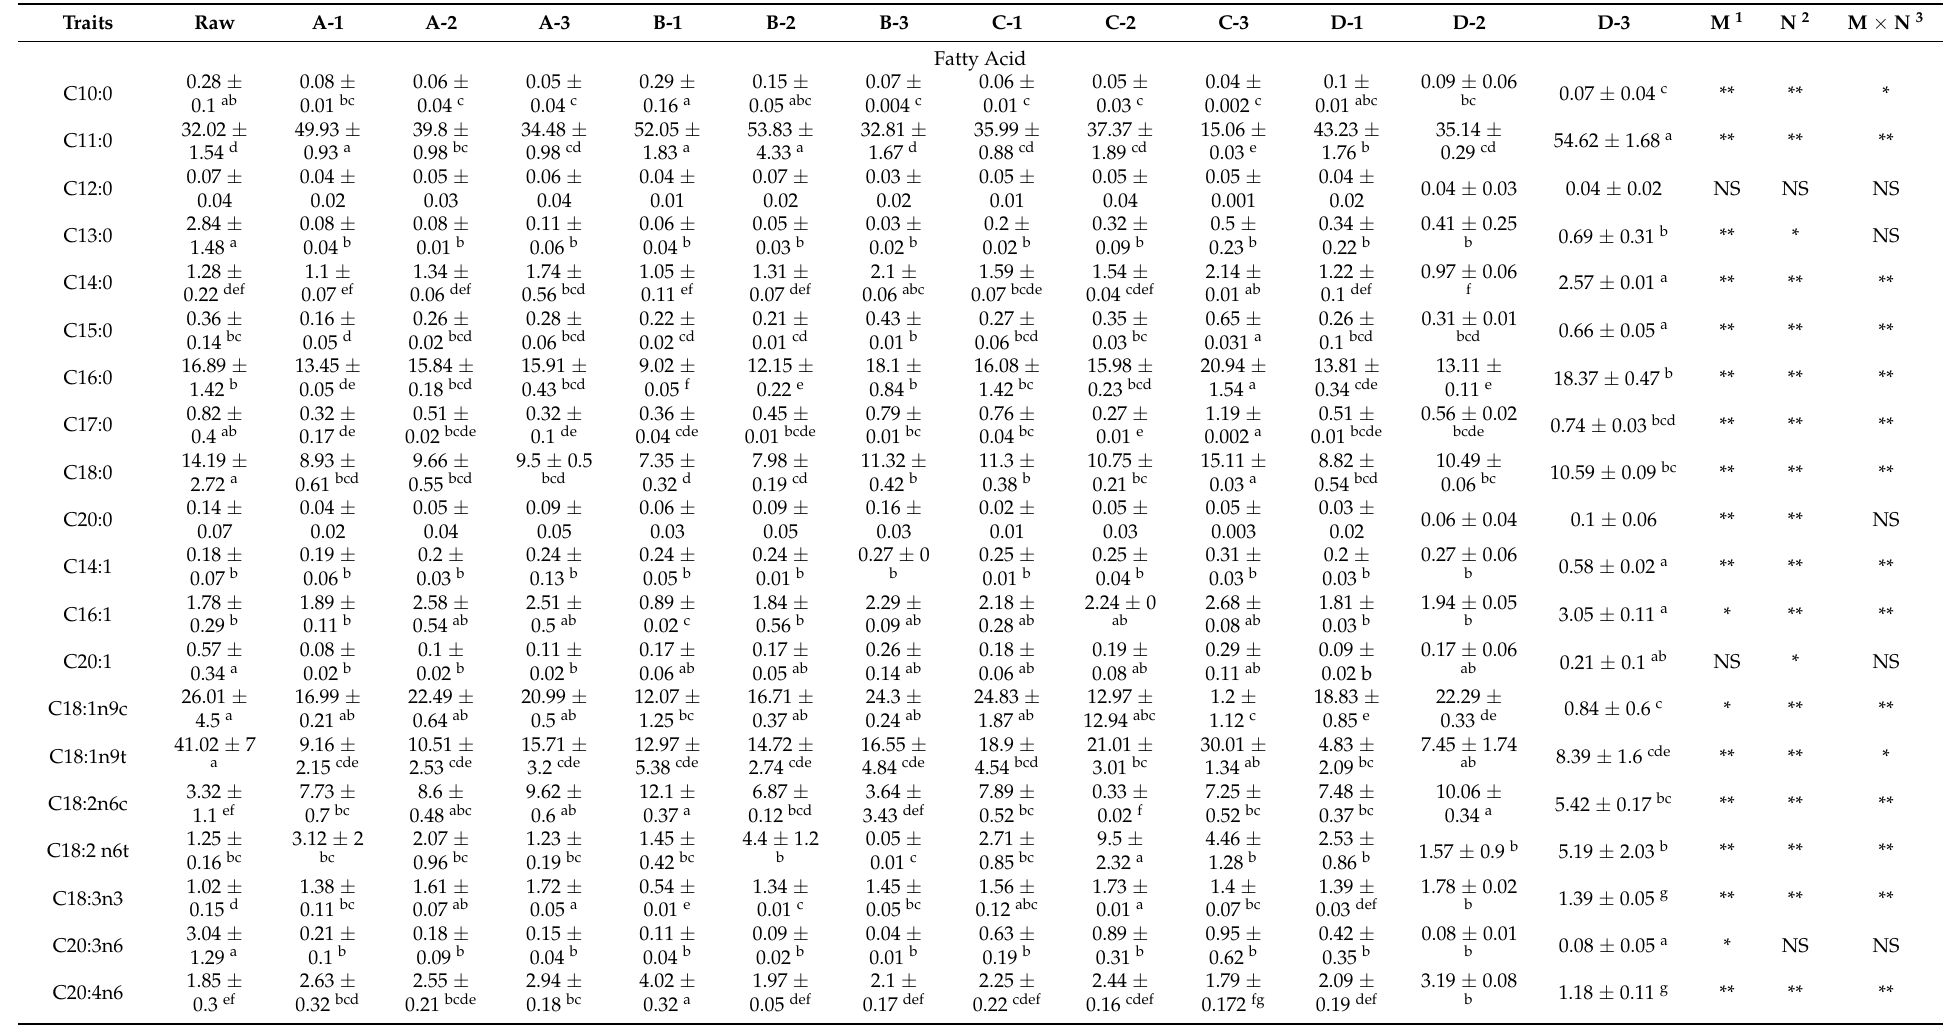
Table 4. Means of fatty acid, 5 (cid:48) -nucleotide, and free amino acid (mg/100 g − 1 ) concentrations in Pingliang red beef under different cooking